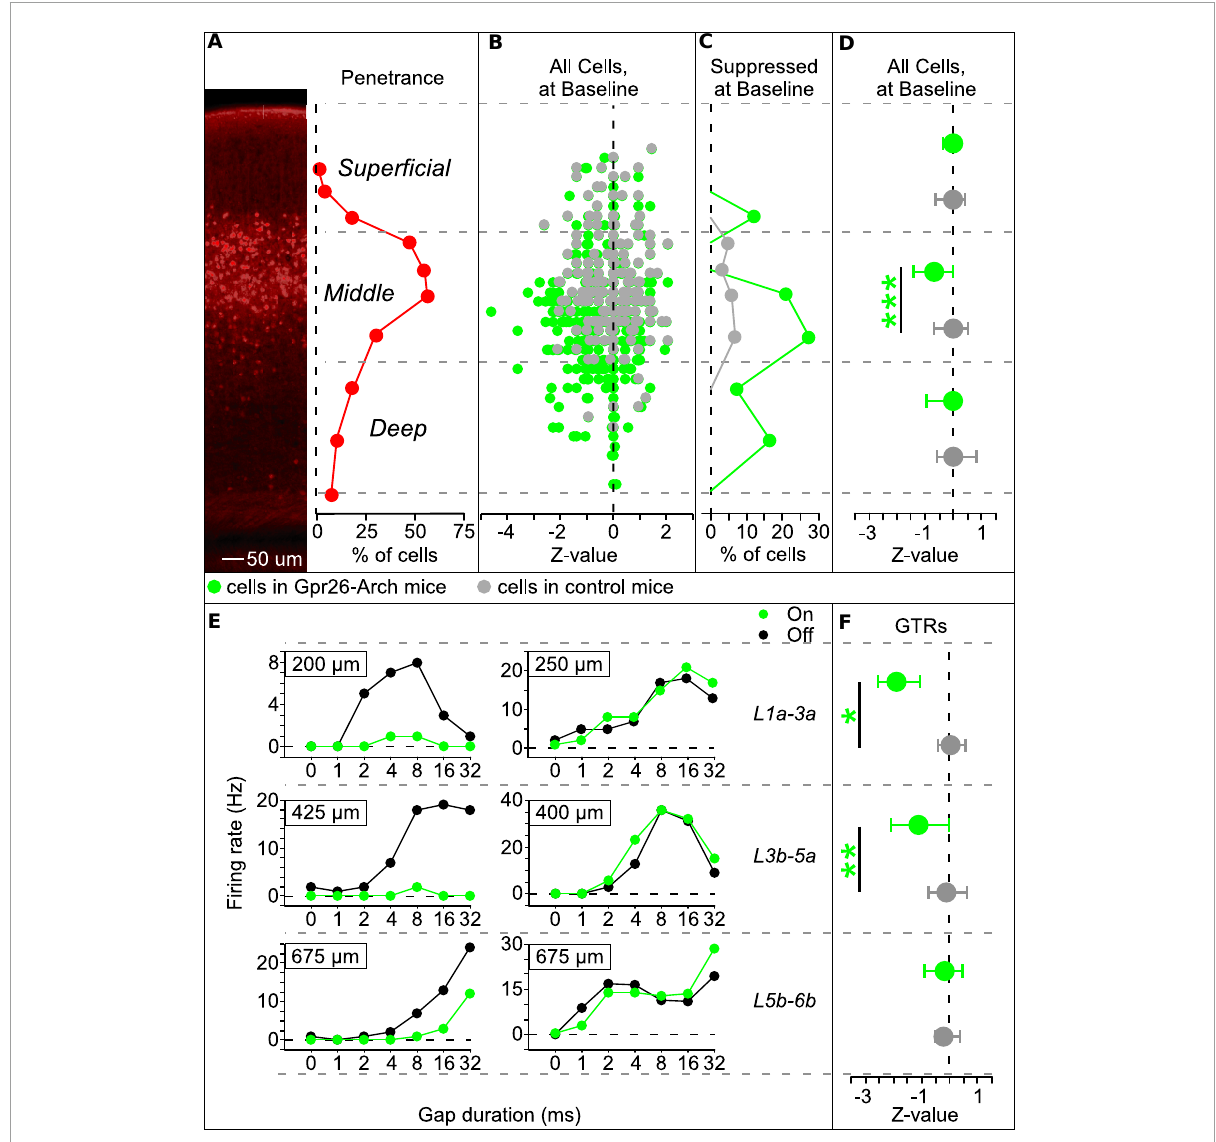
FIGURE2 Illumination suppresses gap termination responses (GTRs) in Gpr26-Arch mice. Spiking activity was recorded using silicon probes during the delivery of gap-in-noise stimuli. Analyses of spiking activity were limited to those cells for which depth could be unambiguously determined, based on current source density analysis (Gpr26-Arch: 280 cells; control: 210 cells). Illuminated (Light-On) trials were interleaved with non-illuminated (Light-Off) trials. Illumination occurred during the 50 ms interval following gaps, and the corresponding interval during gap-free baseline trails. (A) Cells were separated by depth into three groups, those within the range of greatest penetrance of the Gpr26 line (middle layers 3b-5a), and those dorsal and ventral to that range (superficial layers 1a-3a and deep layers 5b-6b, respectively). 100X magnification. (B) Z -values were calculated (Light-On versus Light-Off) for baseline, gap-free trials and then plotted by depth for cells from Gpr26-Arch mice (in green) and controls (in gray). (C) The highest proportion of cells from Gpr26-Arch mice suppressed during gap-free trials were found in the middle layers. Proportions represented the number of cells suppressed in each sublayer divided by the total cells recorded in the sublayer. (D) Suppression was significant in middle layer cells from Gpr26-Arch mice relative to controls. (E) Gap duration tuning curves from 6 example cells. Each panel shows firing rate across different gap durations. Green: photosuppression, black: control. In Gpr26-Arch mice, some GTRs from superficial, middle, and deep layers were suppressed (left-hand column) while others were unaffected (right-hand column). (F) At the population level, GTRs from middle and superficial layers, but not deep layers, were significantly suppressed relative to controls. Dots show medians and error bars show IQR. * p < 0.05; ** p < 0.01; *** p < 0.0001, rank-sum.